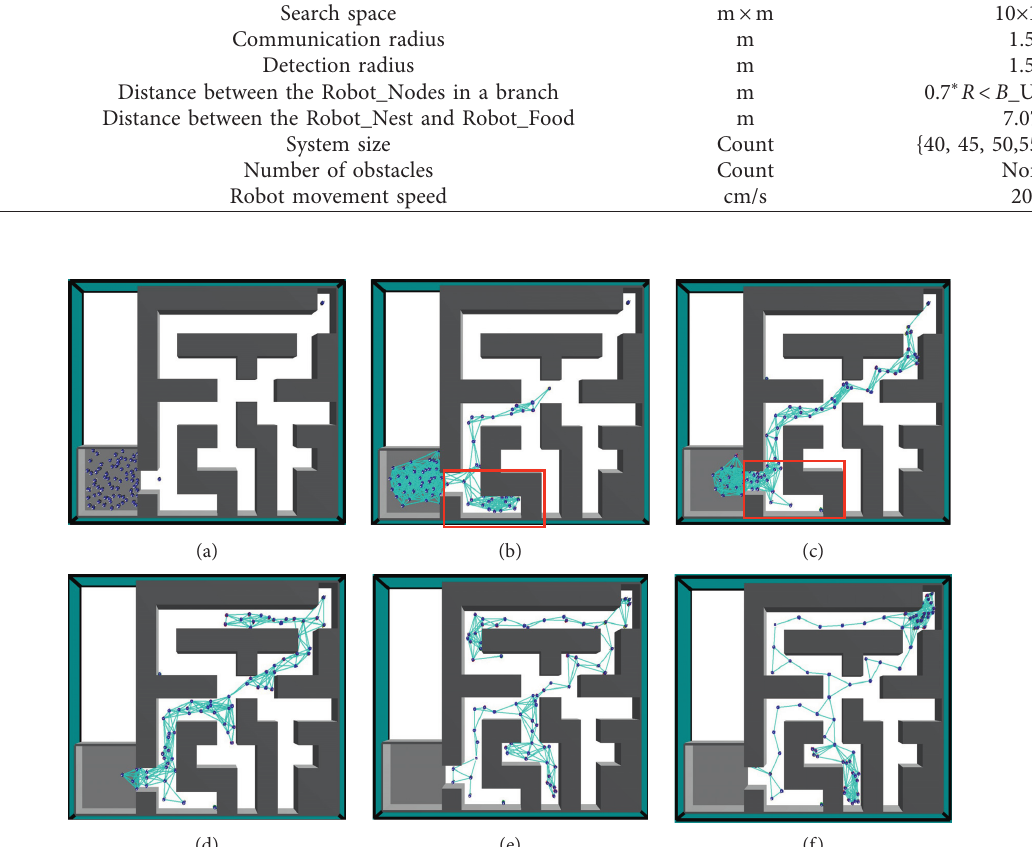
Figure 9: The simulation process. (a) 0 time steps. (b) 708 time steps. (c) 1418 time steps. (d) 2126 time steps. (e) 2835 time steps. (f) 3544 time steps.